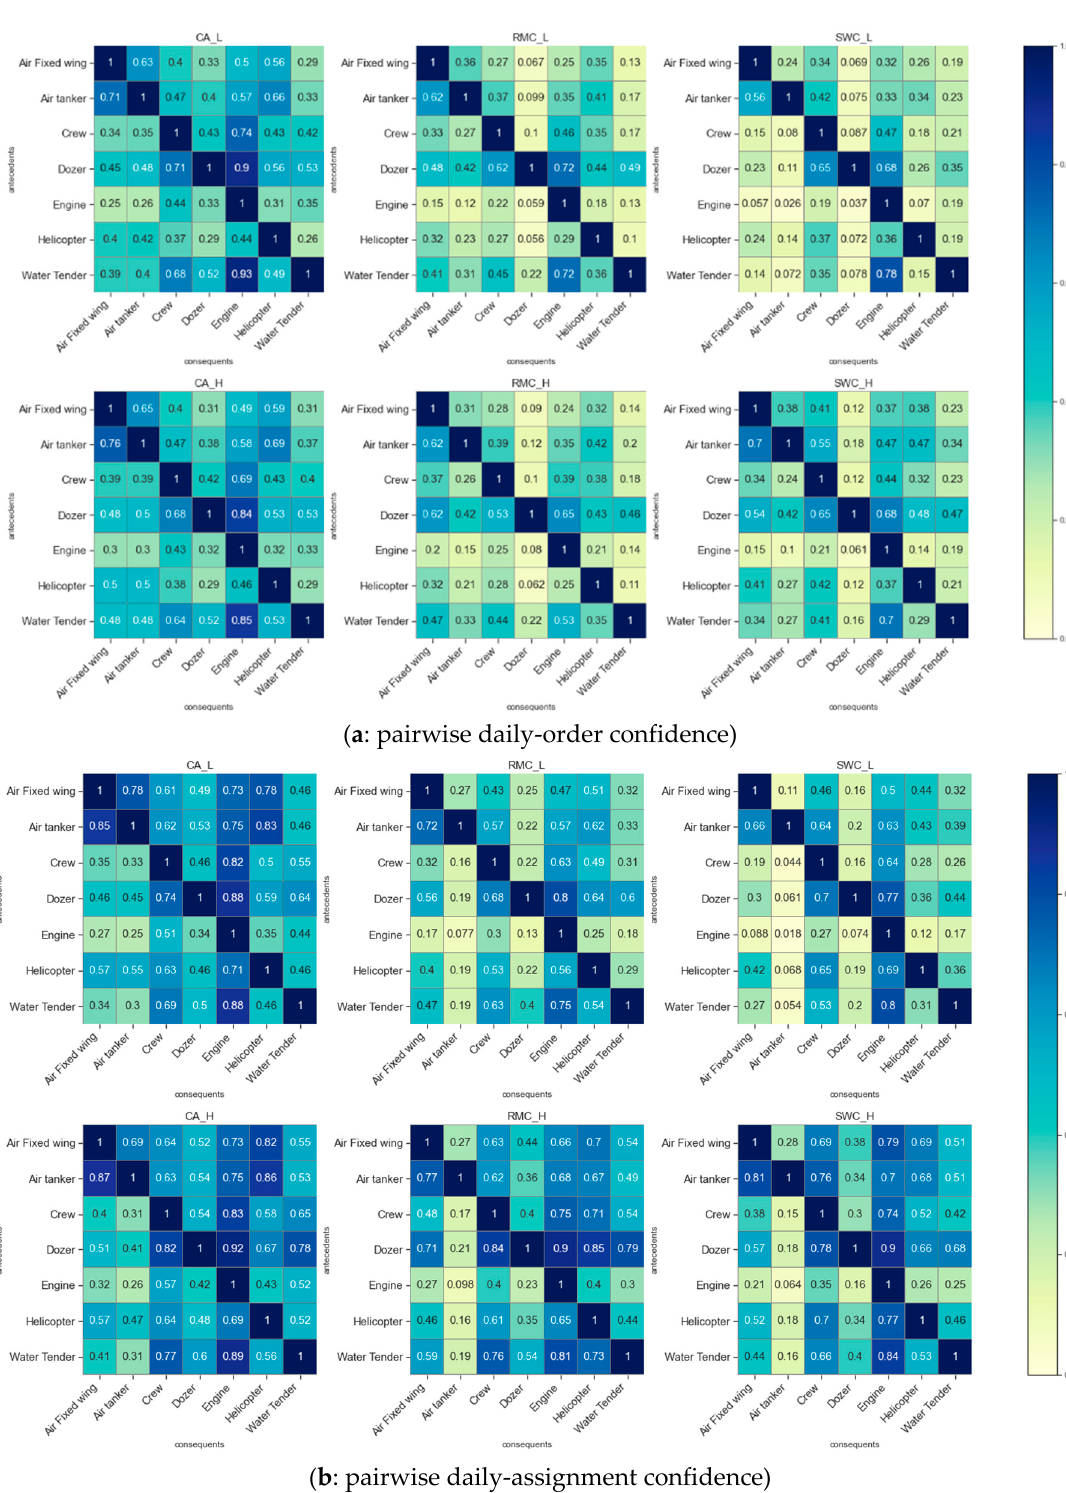
( a : pairwise daily ‐ order confidence)